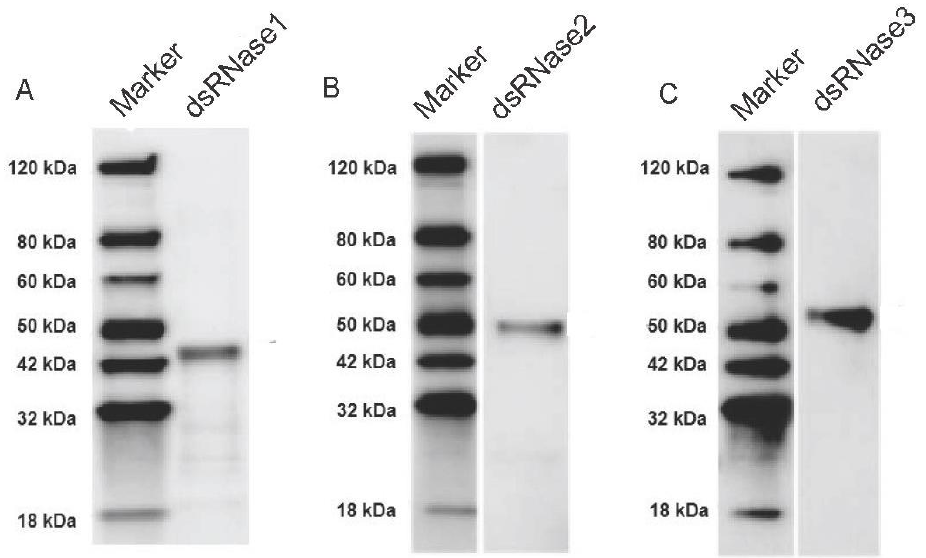
Figure 8. Western blot analysis of recombinant PxdsRNase proteins. Electrophoresis was performed in 12% SDS-PAGE gel. The separated protein was transferred to membrane (100 V for 100 min). After blocking with 5% w / v BSA (Solarbio, Beijing, China), each protein was incubated with His monoclonal antibody (GenScript, Nanjing, China), separately. The EstinTM L1 staining kit (GenScript, Nanjing, China) was used for signal generation. The arrows point to the target proteins.